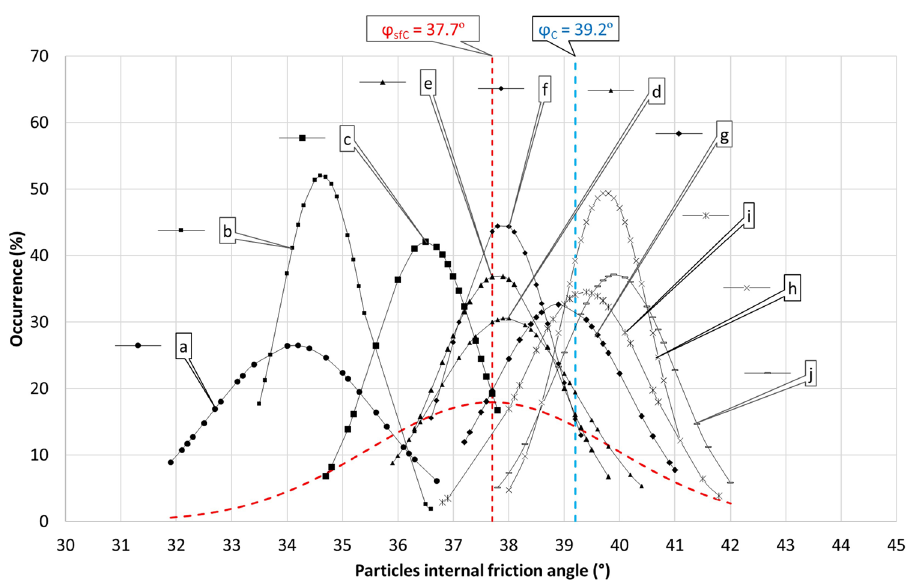
Figure 6. Gaussian distribution φ sf for individual samples, for the whole set of samples φ sfC and mean probable angle of internal friction of particles φ